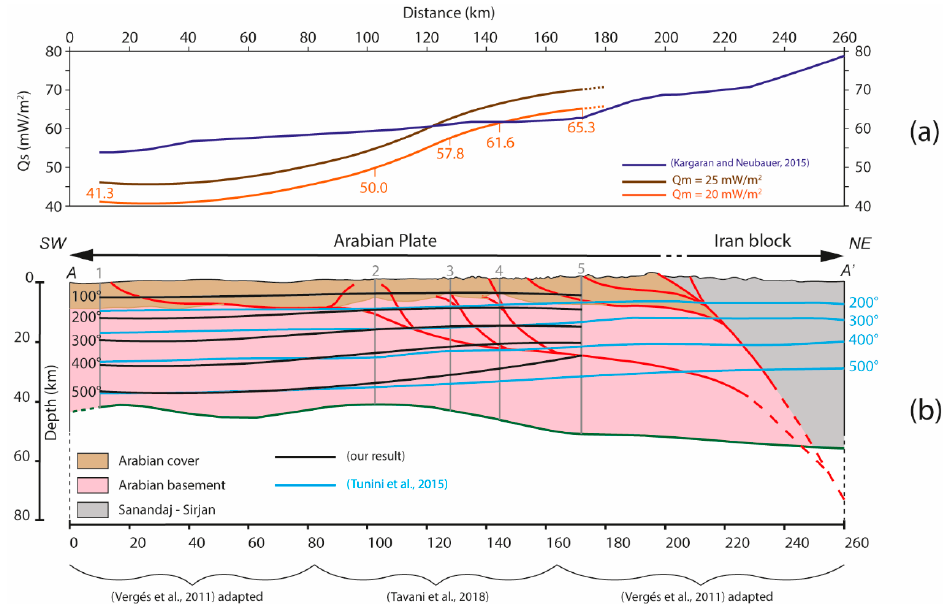
Figure 7. ( a ) Surface heat flow (Qs) curves obtained for Qm values of 20 and 25 mW/m 2 , compared with the Kargaran and Neubauer [40] curve. ( b ) Thermal structure of the study area, compared with the isotherms by Tunini et al. [8].